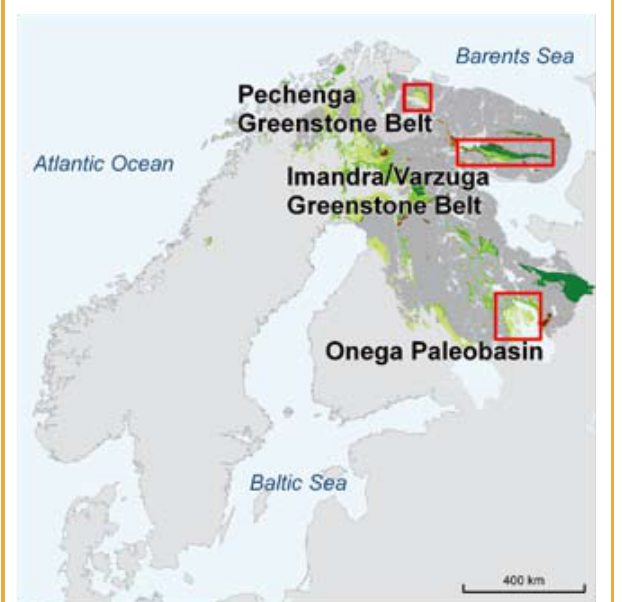
Figure 2. Global environmental events associated with the GOE, and targeted by FAR-DEEP (Holland, 2002).